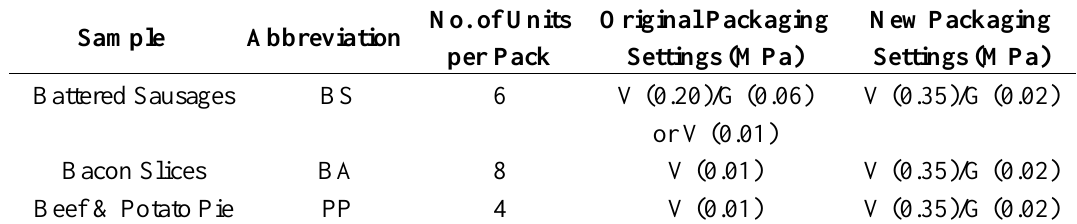
Table 1. Sample list with packaging settings (Vacuum—V/Gas—G) expressed in